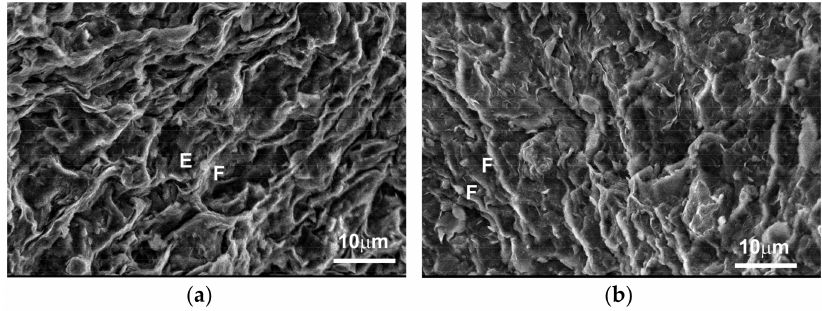
Figure 13. ( a ) Fabric of freshwater clay; ( b ) Fabric of saline